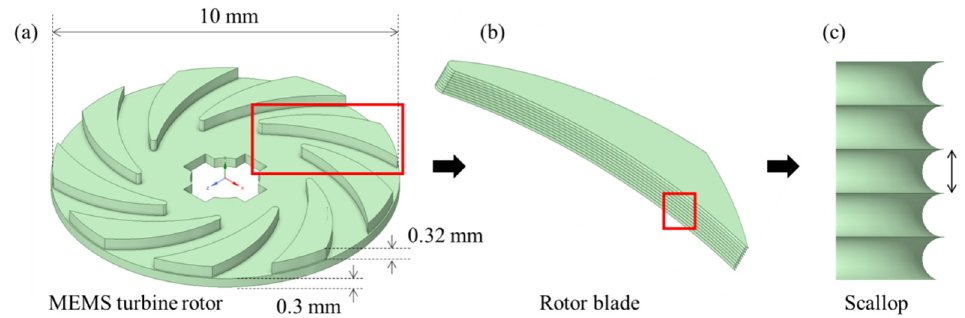
Figure 1. ( a ) Proposed MEMS turbine rotor, ( b ) rotor blade, and ( c ) sidewall scallop of the rotor blade.